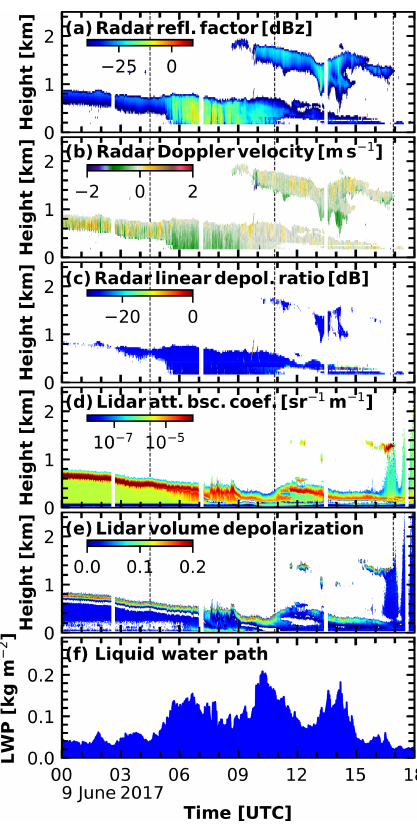
Figure 10. OCEANET observations on 9 June 2017 between 00:00 and 18:00UTC. Panels (a) , (b) , and (c) show the radar reflectiv- ity factor, Doppler velocity, and linear depolarization ratio. Pan- els (d) and (e) depict the lidar attenuated backscatter coefficient at 1064nm and volume depolarization ratio at 532nm. In panel (f) the liquid water path derived by the microwave radiometer is shown. The dashed vertical lines mark the time of the radiosonde launches on 9 June 2017 (note: the time of the first launch shown in Fig. 9 was before the plotted profiles of the measurements